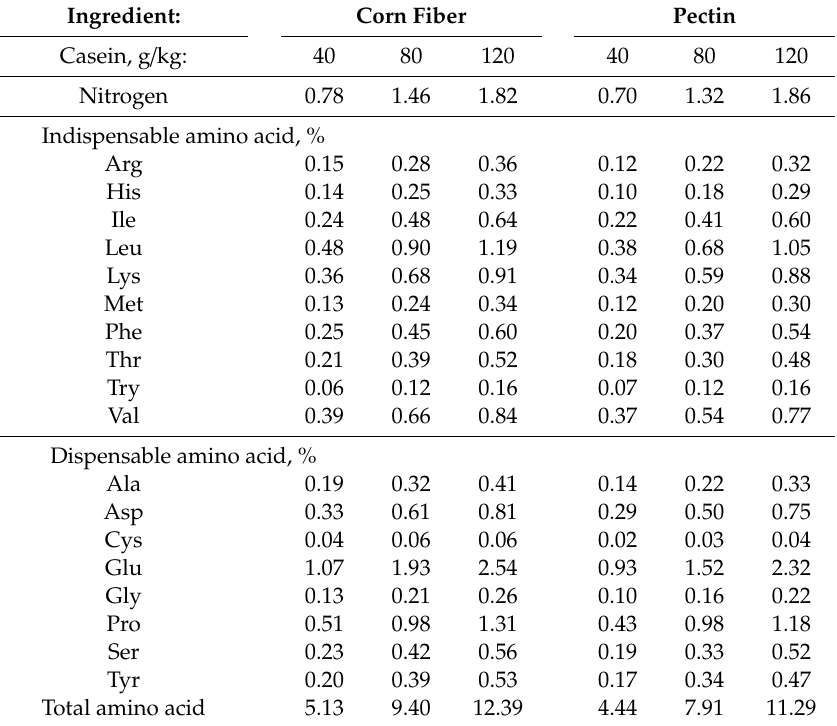
Table 5. Analyzed amino acid contents of the experimental diets fed to pigs (Exp. 2; on as-fed